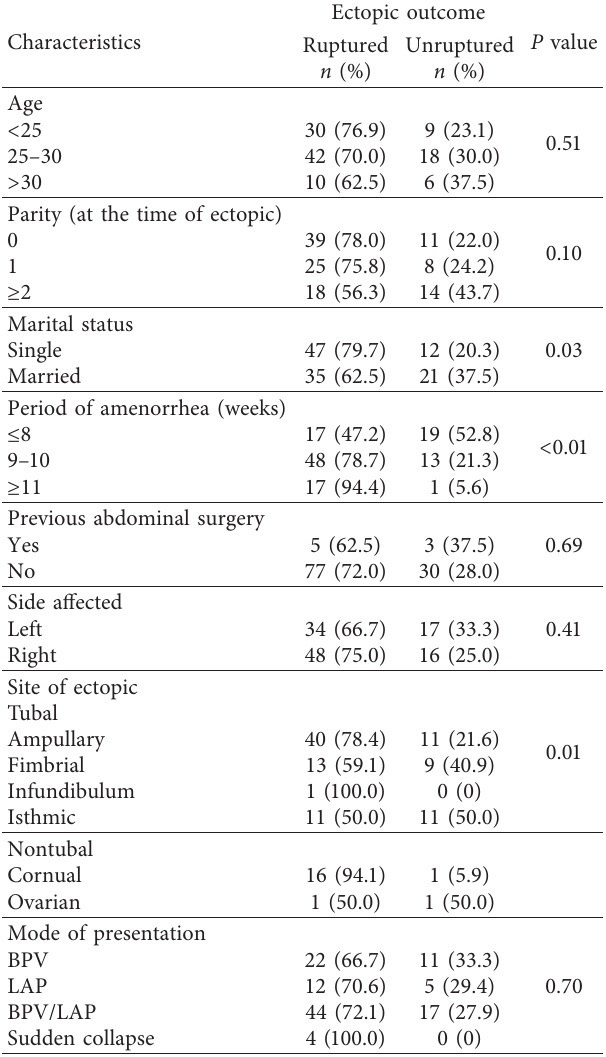
Table 1: Demographic characteristics of study participants.